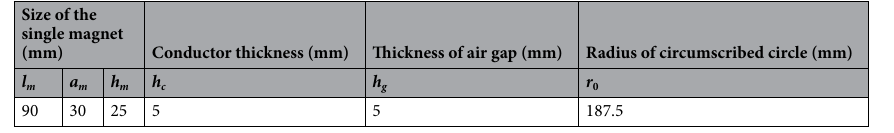
Table 1. Size parameters of the permanent magnet speed